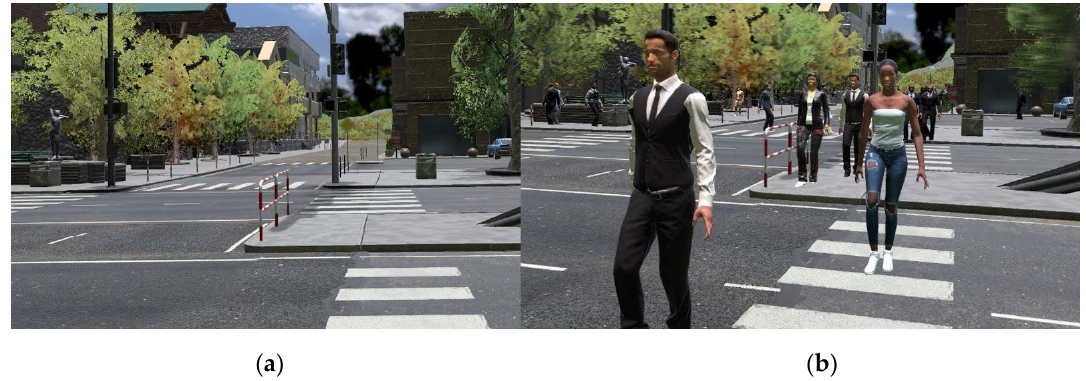
Figure 3. Environment without animation and moving elements ( a ), environment with animations and moving elements ( b ).